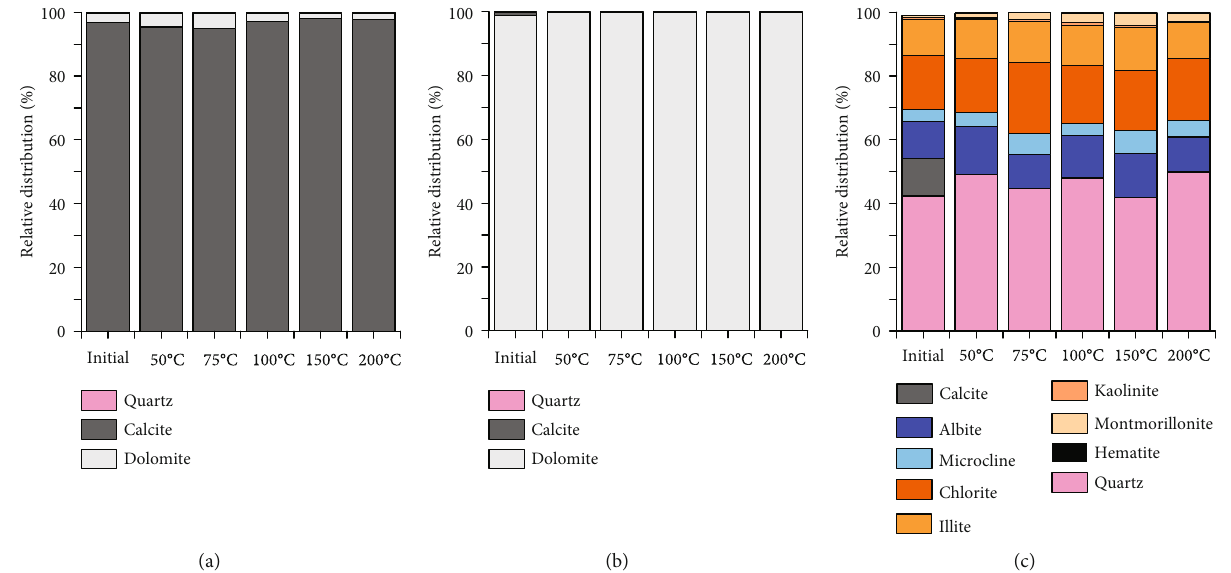
Figure 3: Mineralogical composition of initial and altered rock grains: (a) limestone series; (b) dolostone series; and (c) sandstone series. “ Initial ” describes initial rock grains. All data were normalized to 100%.